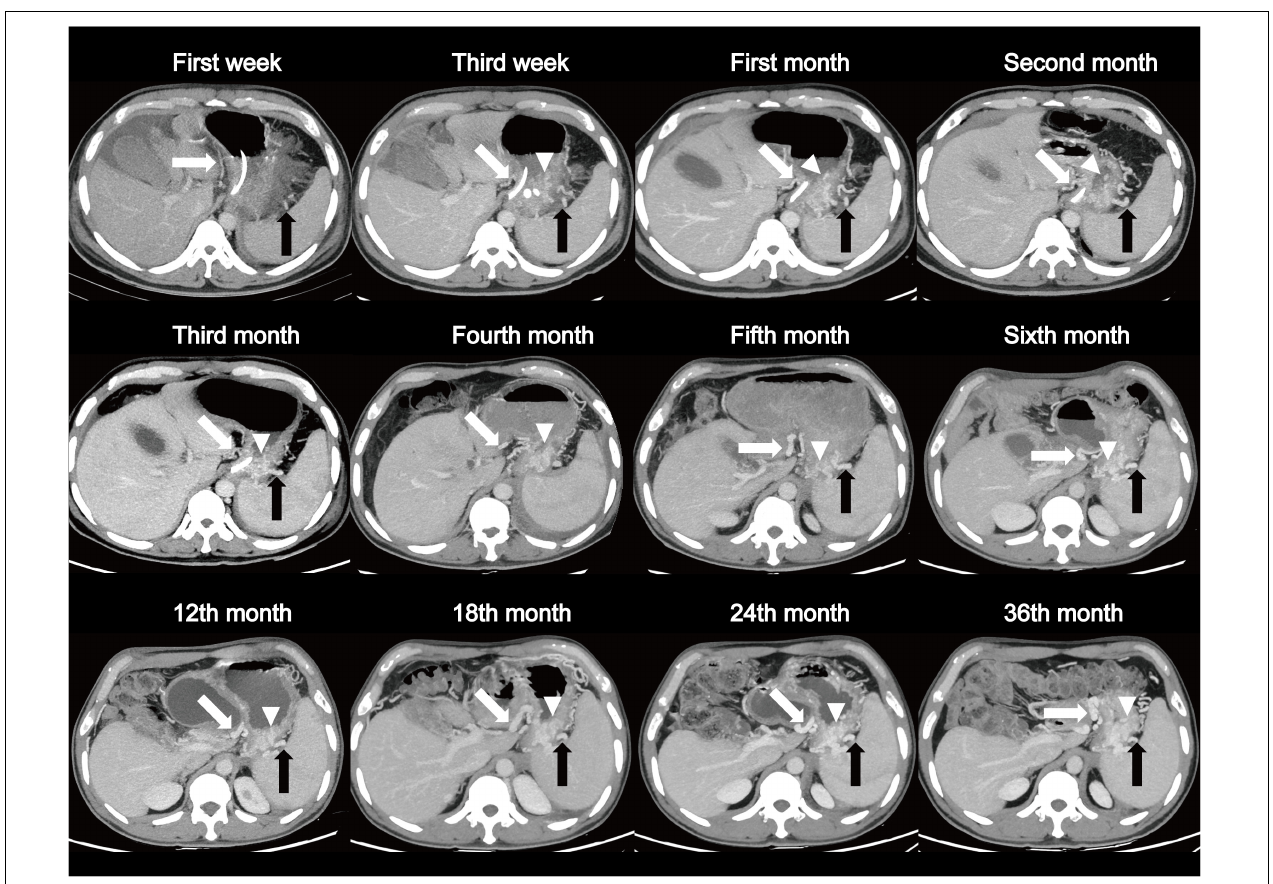
FIGURE 5 | A patient, 39-year-old male, diagnosed as SAP complicated with SPH involving gastric fundus vein (arrow head), short gastric vein (black arrow), and gastric coronary vein (white arrow). Dynamic changes show a long-term, slowly progressing course of SPH over 3 years of follow-up. SAP, severe acute pancreatitis; SPH, sinistral portal